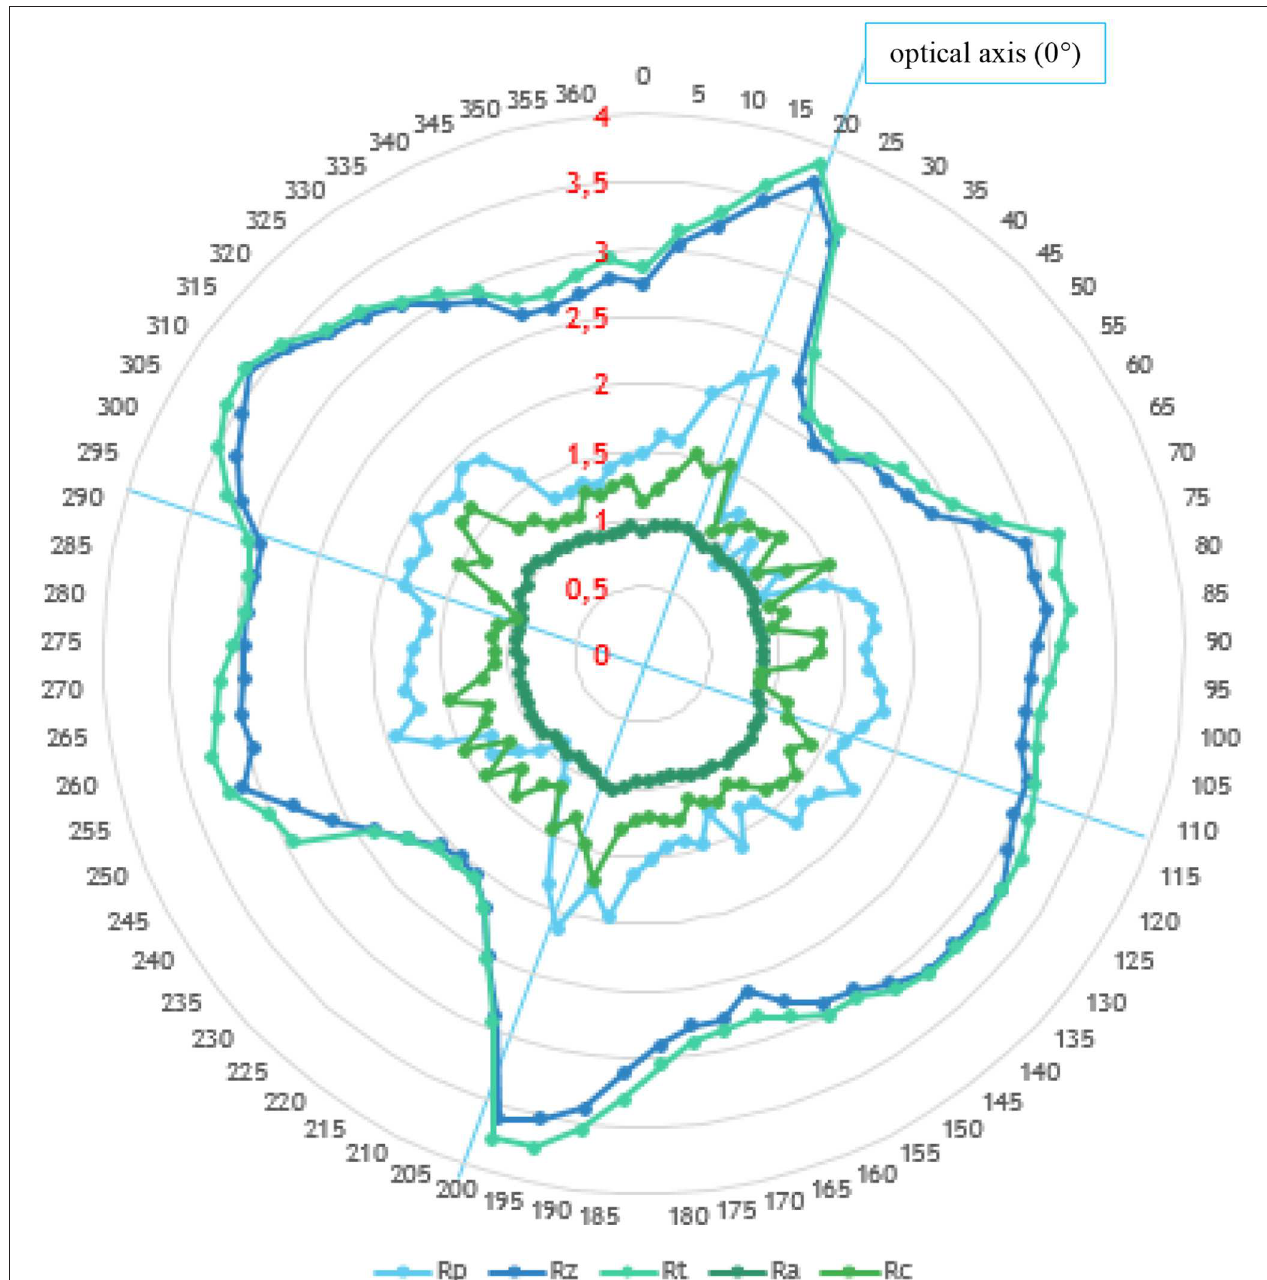
FIGURE 10 | Graphic representation of surface parameters depending on the angle of polarizer’s optical axis in relation to the surface.